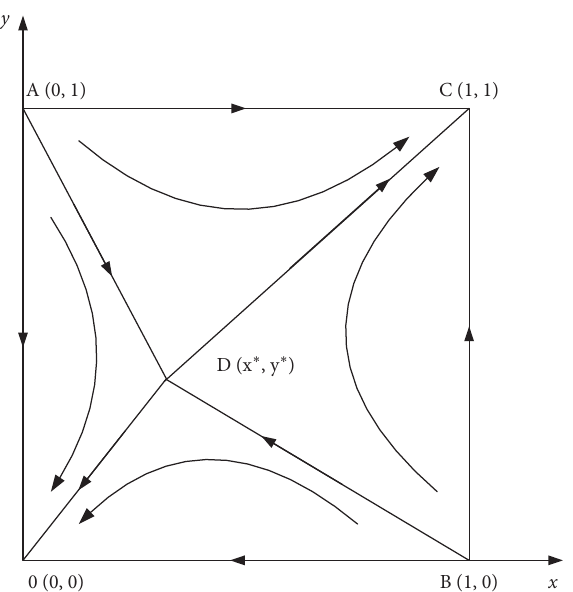
Figure 4: Evolutionary game phases diagram in situation IX. In this situation, origin O (0, 0) and point C (1, 1) are ESS, and point D ( x ∗ , y ∗ ) is the saddle